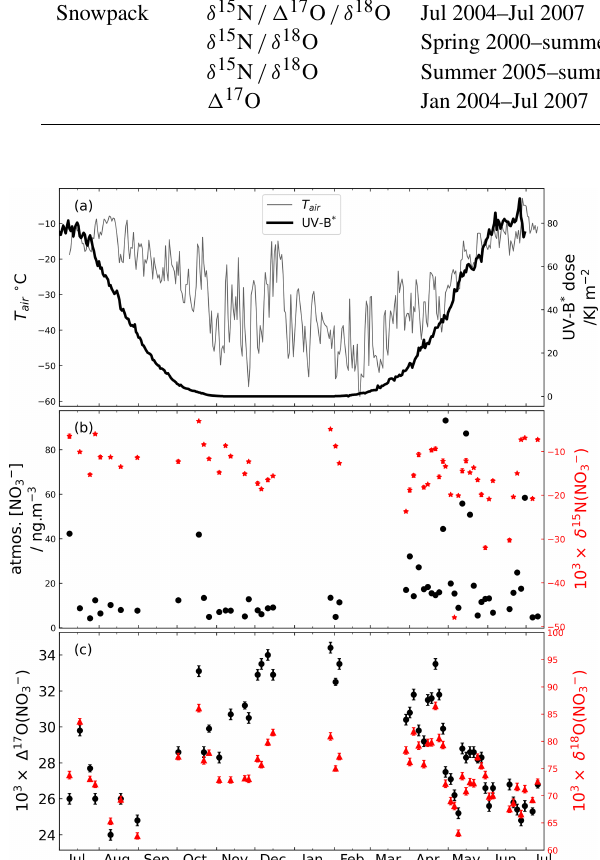
Figure 1. Atmospheric nitrate concentrations and isotopes at Sum- mit over the sampling period (July 2001 to July 2002). (a) Daily air temperature and observed UV-B ∗ (280–320nm) dose at Sum- mit, Greenland, from July 2001 to July 2002 (data source: NSF Arctic Data Center, link: https://arcticdata.io/catalog/data, last ac- cess: 13 June 2022), (b) NO − concentration (black circle) and 3 δ 15 N(NO − ) (red star), and (c) (cid:49) 17 O(NO − ) (black circle) and 3 3 δ 18 O(NO − ) (red 3